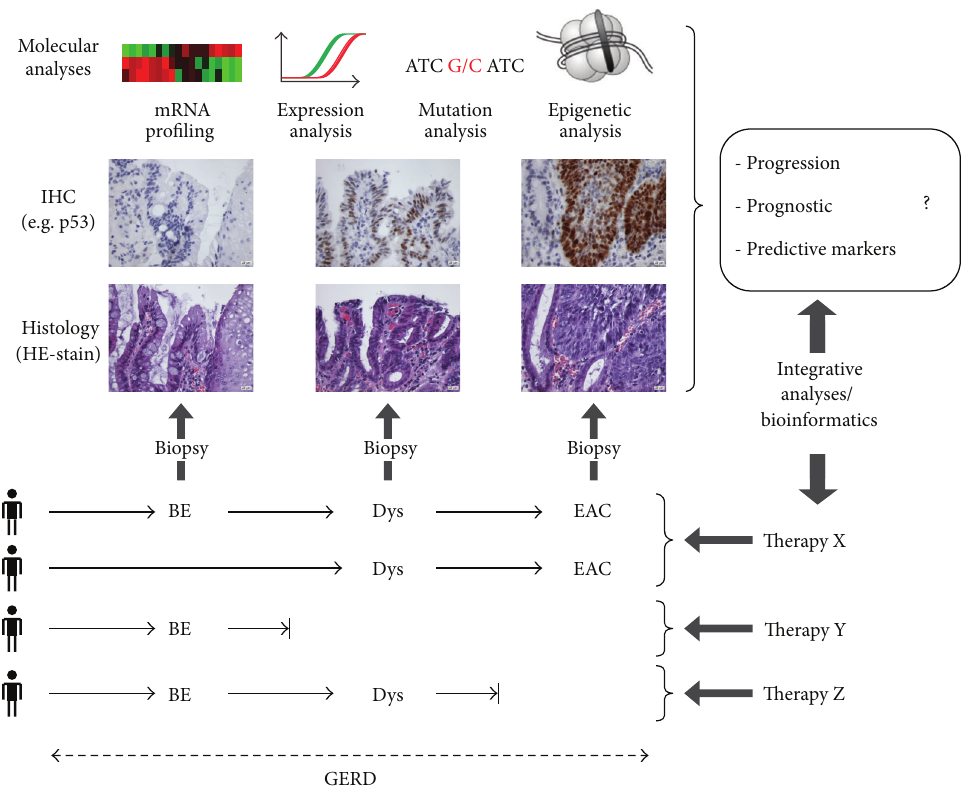
Figure2:ProposedapproachforidentificationofnovelbiomarkersfortheGERD-BE-AECsequence.Basedontheheterogeneousandpatient- specific progression sequence from BE to EAC, the figure indicates the disease stages and mandatory (histology, IHC) and supplementary potential methods for investigation of putative biomarkers for progression, prediction, and prognosis. These data possibly result in an evidence-based stratification of patients for various available therapies (X–Z) based on a rational selection and evaluation of specific biomarkers. Abbreviations. Esophageal adenocarcinoma: AEC; dysplasia: Dys; fluorescence in-situ hybridization: FISH; gastro-esophageal reflux disease: GERD; immunohistochemistry: